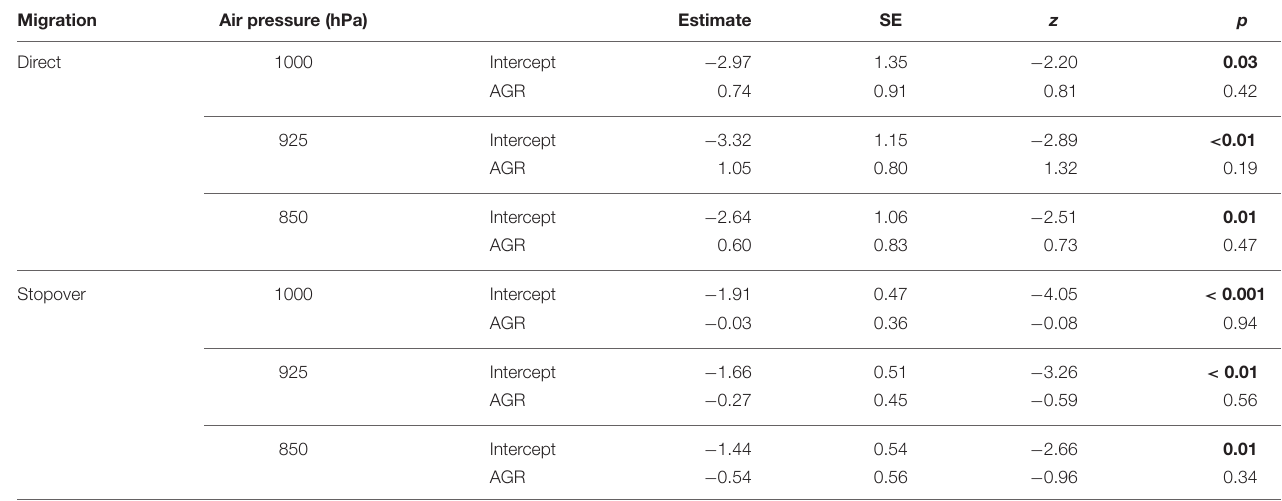
TABLE 2 | Generalized linear models testing the influence of air-to-ground speed ratio (AGR) at the wintering site, on the departure decision of Icelandic whimbrels undertaking a direct ( n = 72) or stopover migration ( n = 376). Migration Air pressure